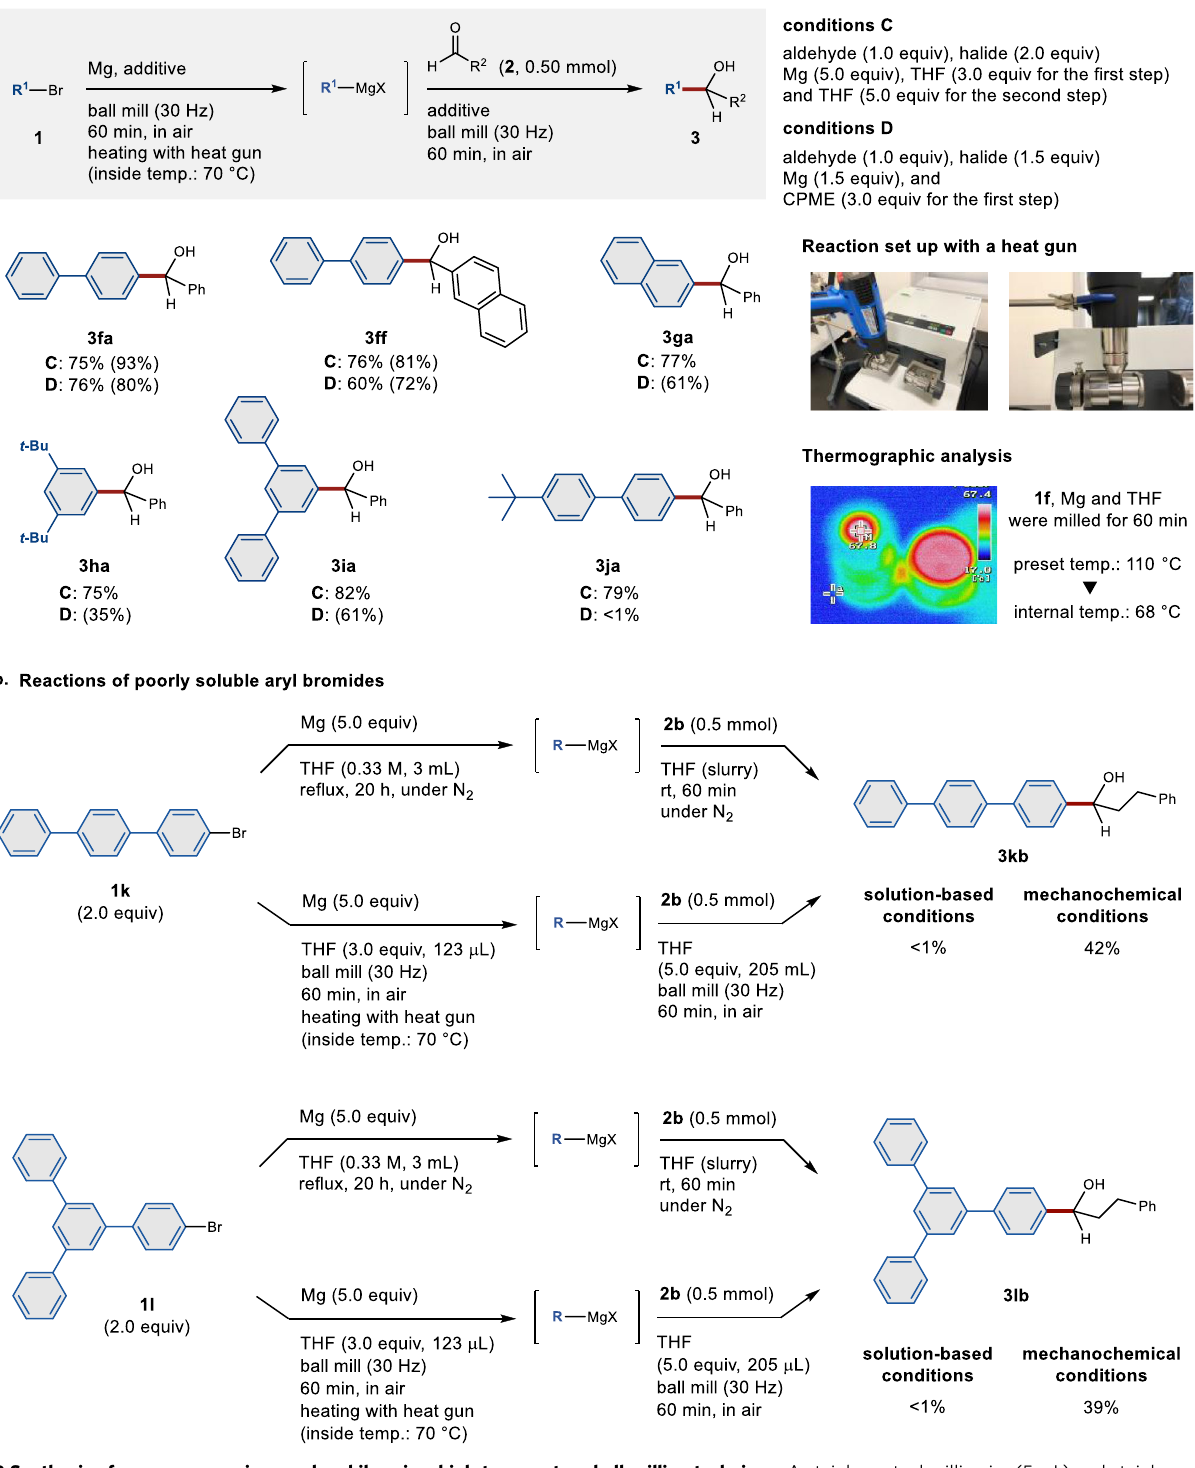
Fig. 3 Synthesis of organomagnesium nucleophiles via a high-temperature ball-milling technique. A stainless-steel milling jar (5 mL) and stainless-steel ball (diameter: 10 mm) were used; for details, see the Supplementary Information. Isolated yields are reported as percentages. Proton NMR integrated yields are shown in parentheses. a Mechanochemical synthesis of magnesium-based carbon nucleophiles from solid aryl halides. b Mechanochemical conditions allowed the formation of magnesium-based carbon nucleophiles from poorly soluble aryl halides 1k and 1l , which are not readily applicable to the conventional solution-based